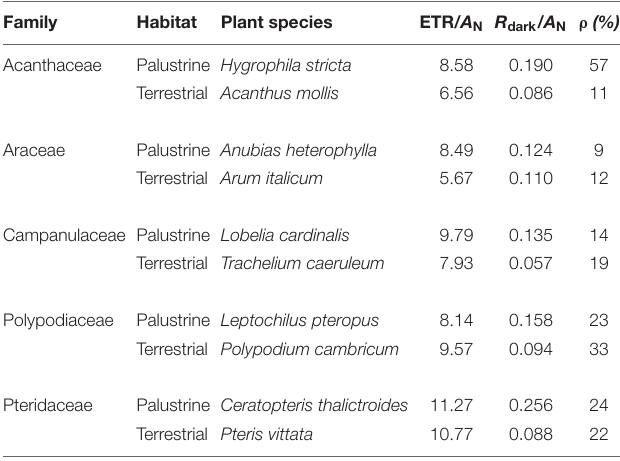
TABLE 3 | General characteristics of the studied terrestrial and palustrine plant species: the ratio of electron transport rate (ETR) to net photosynthesis ( A N ), the ratio of dark respiration ( R dark ) to A N , and the ratio of v alt to V alt ( ρ